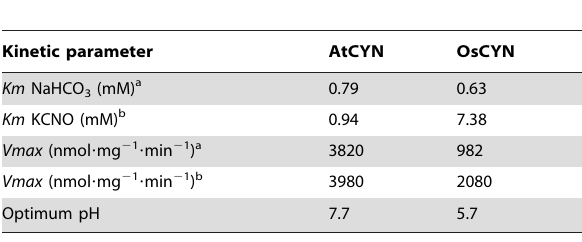
Table 2. Biochemical characteristics of heterologously expressed AtCYN and OsCYN.